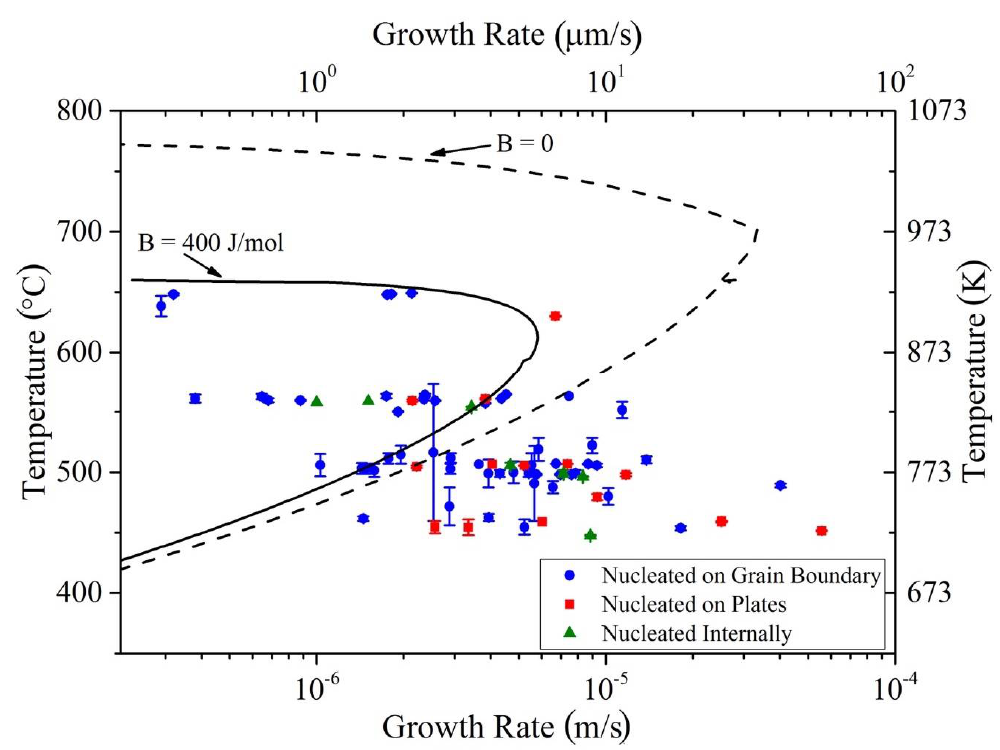
Figure 17. Predicted maximum lengthening rates with Equation (3) in logarithmic scale and the experimentally-recorded growth data at different temperatures.